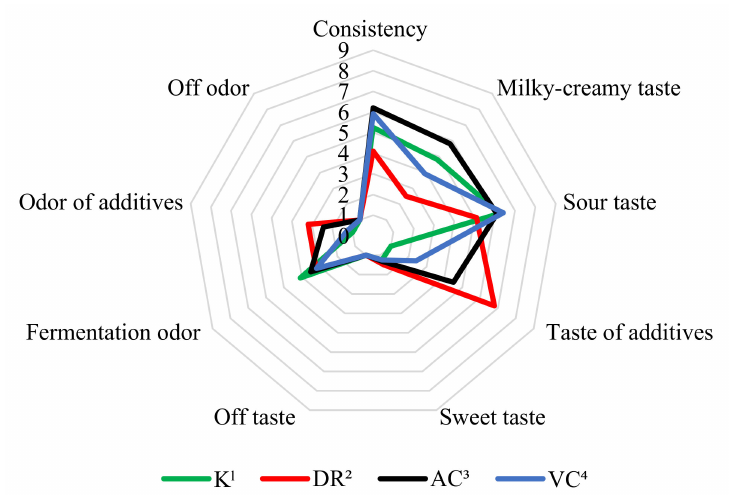
Figure 3. Effect of added different source of vitamin C on organoleptic parameters of fermented milk by L. rhamnosus after 21st day of storage; 1 —control milk; 2 —fermented milk with rosehip; 3 —fermented milk with acerola; 4 —fermented milk with L(+)ascorbic